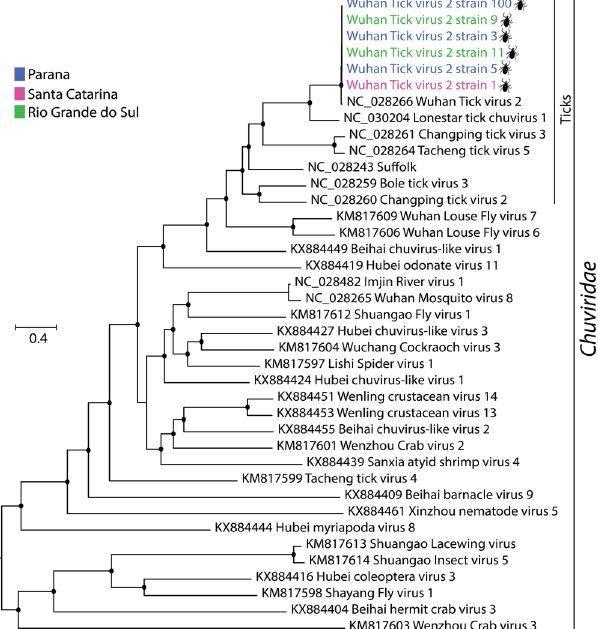
Figure 3. Maximum likelihood phylogeny of new strains of Wuhan tick virus 2 into Chuviridae family. Phylogeny was constructed on amino acids alignments sequences with RNA-dependent RNA polymerase based on LG + I + G4 amino acids substitution model. Phylogeny was midpoint rooted for clarity of presentation. The scale bar indicates evolutionary distance in numbers of substitutions per amino acids sites. Taxons are colored according to geographical location, and the host was denoted with a silhouette. The legends for the colors are shown on the left. The black circles indicate the main nodes with maximum likelihood bootstrap support levels above 75% bootstrap